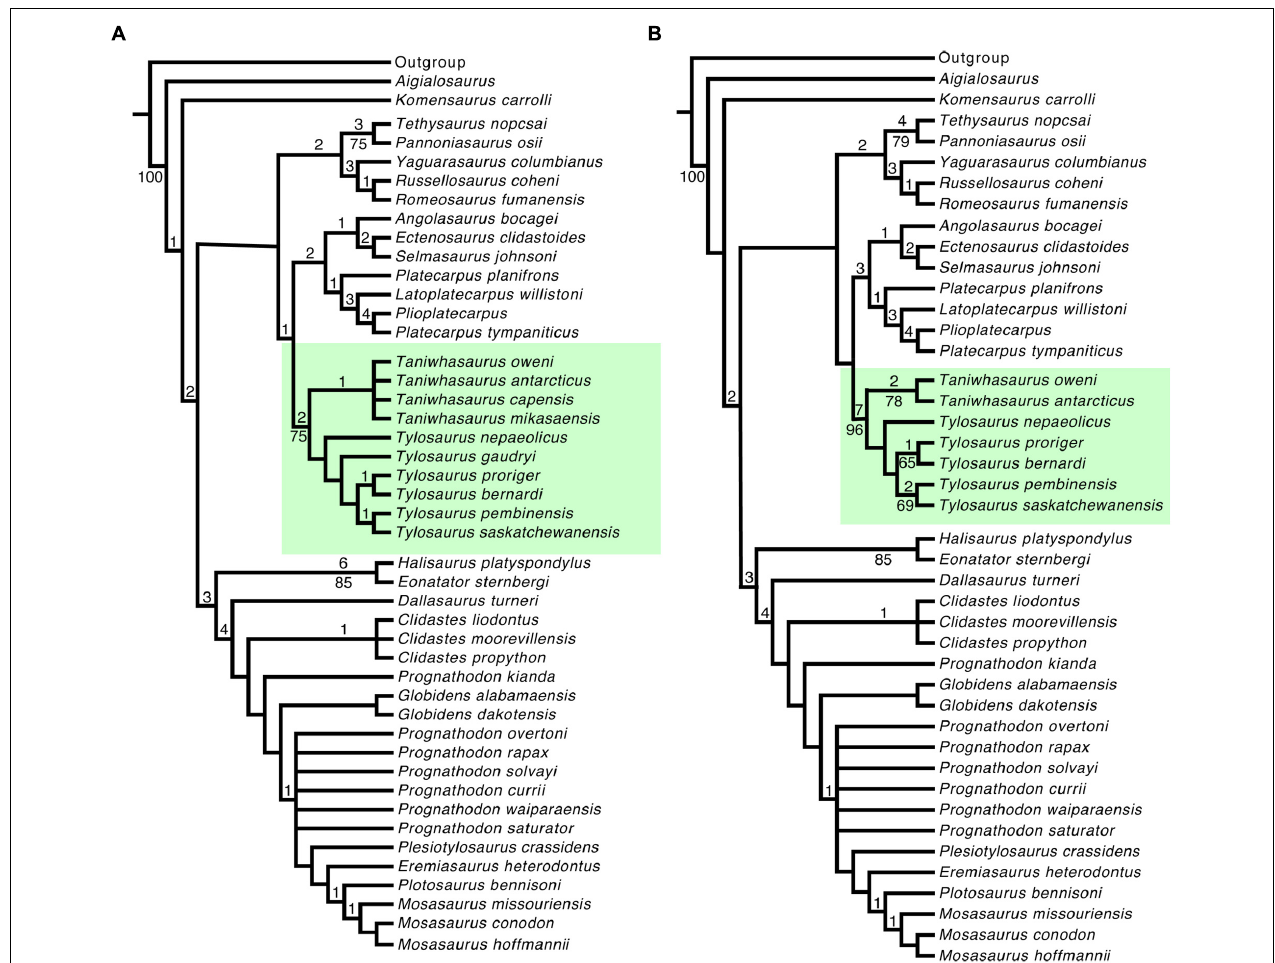
FIGURE 2 | Majority Rule Consensus trees: (A) Majority Rule Consensus tree obtained from 218 most parsimonious trees (MPTs) of 451 steps (C.I. = 0.3503; R.I. = 0.7169) of all tylosaurine species; (B) Majority Rule Consensus tree obtained from 103 MPTs of 448 steps (C.I. = 0.3527; R.I. = 0.7134), excluding T. gaudryi , Taniwhasaurus indet. 1 ( Ta. ‘mikasaensis’ ), and Taniwhasaurus indet. 2 ( ‘T’. capensis ). Values above nodes indicate Bremer (decay) indices, and below nodes indicate Bootstrap indices (only values over 50% are